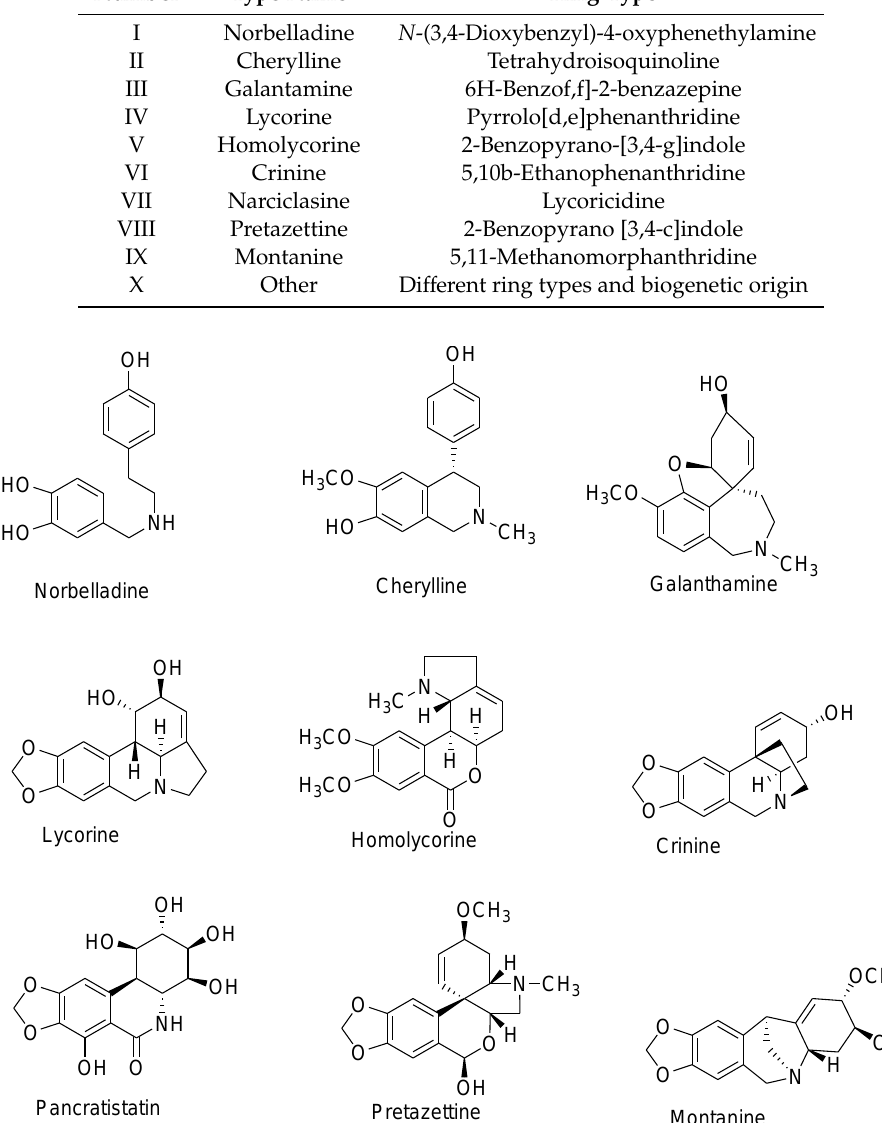
Figure 1. Representative Amaryllidaceae alkaloid structure for the main Amaryllidaceae alkaloid (AA)-types.